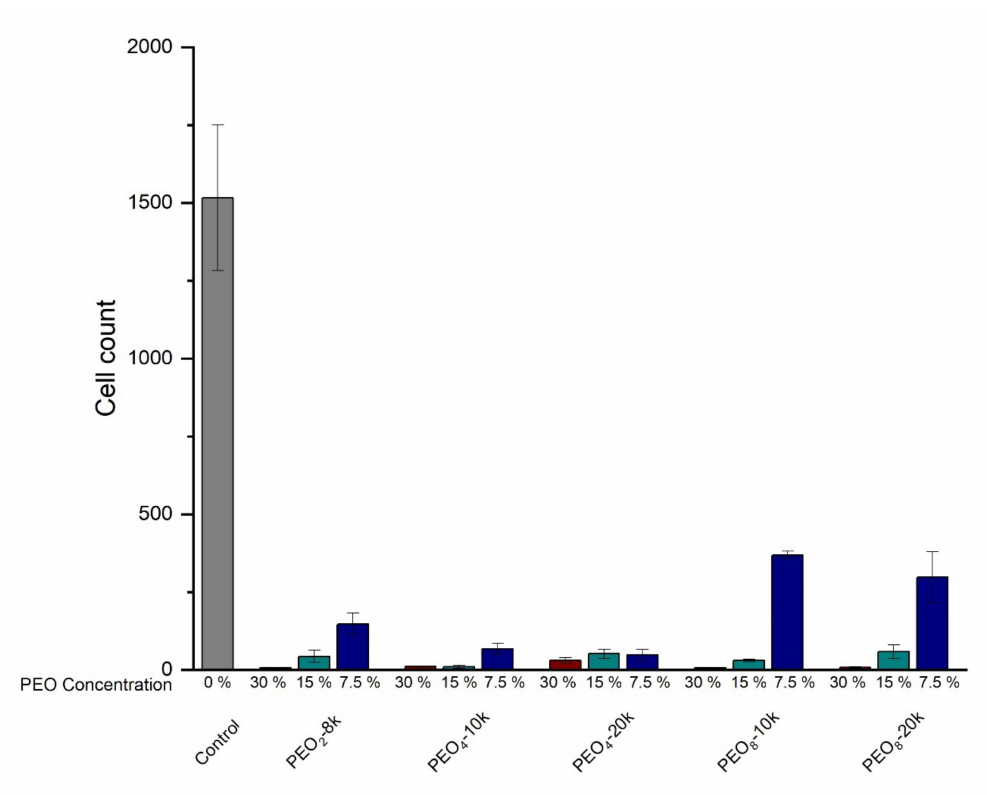
Figure 5. T0523 Cell survival in the presence of various concentrations of PEO stars (3 replicants). At all concentrations above 7.5% w / v , there was significant inhibition of cell